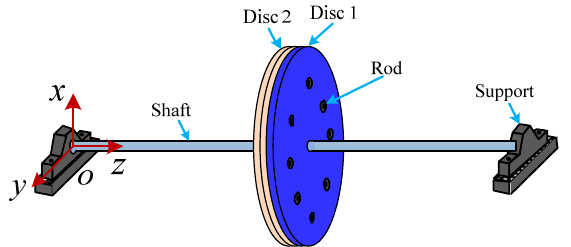
Figure 1. A rod fastening rotor with disc contact.